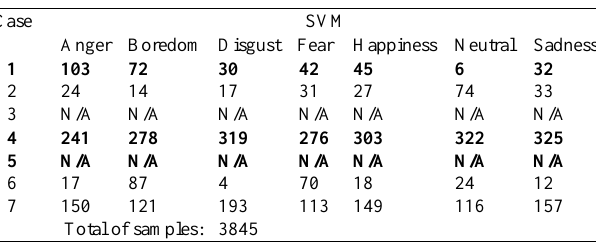
Table 2: Performance of SVM for offline samples.